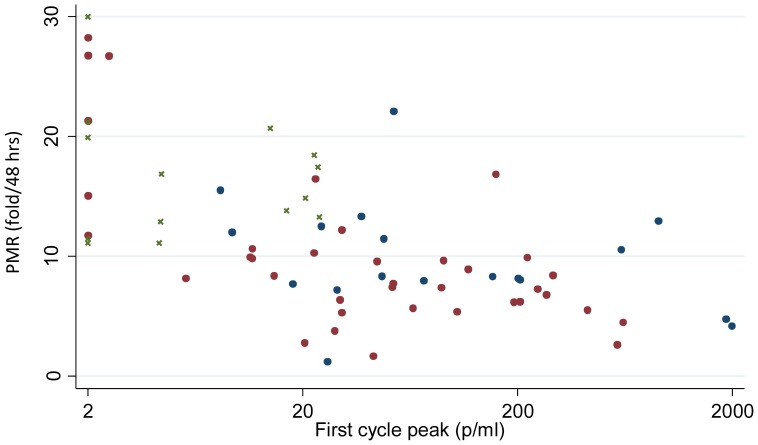
Parasite Multiplication Rate following PfSPZ Challenge is comparable to mosquito-bite subjects with similar LBIs.Figure shows relationship Between PMR and LBI for participants successfully infected with malaria in groups 1–3 (green crosses), compared to historical data from mosquito bite CHMI trials undertaken at our centre involving malaria naïve unvaccinated subjects (blue dots), and malaria naïve ChAd63-MVA ME-TRAP vaccinated subjects (red dots). These data were obtained using the linear model; results were similar with the sine model (data not shown).